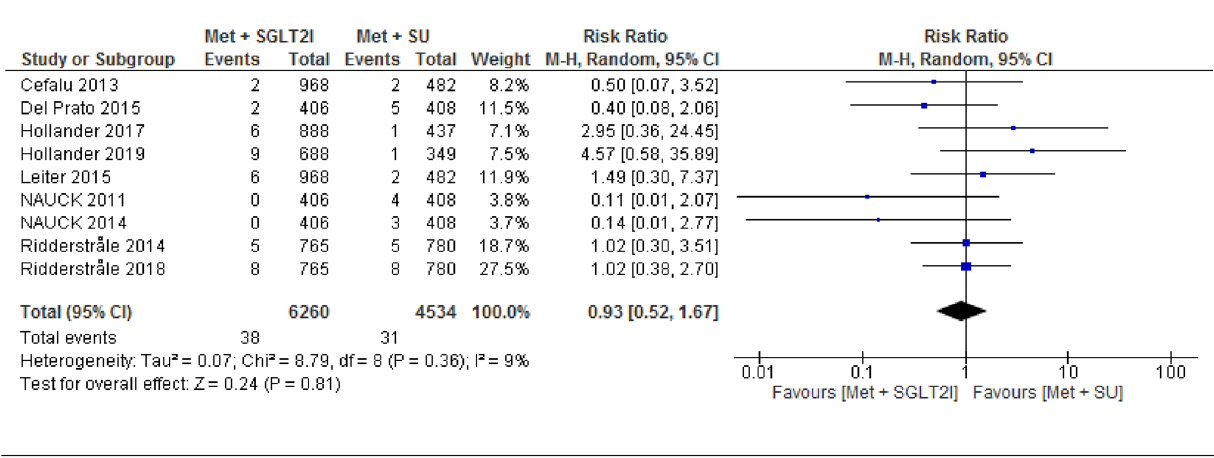
Figure 3. Comparison of all-cause mortality/death events between patients with T2DM who were on metformin-SGIT2I and metformin-sulphonylureas combination therapies. RR risk ratio; CI confidence interval; df degrees of freedom; Met metformin; SGLT2I sodium-glucose co-transporter 2 inhibitor; SU